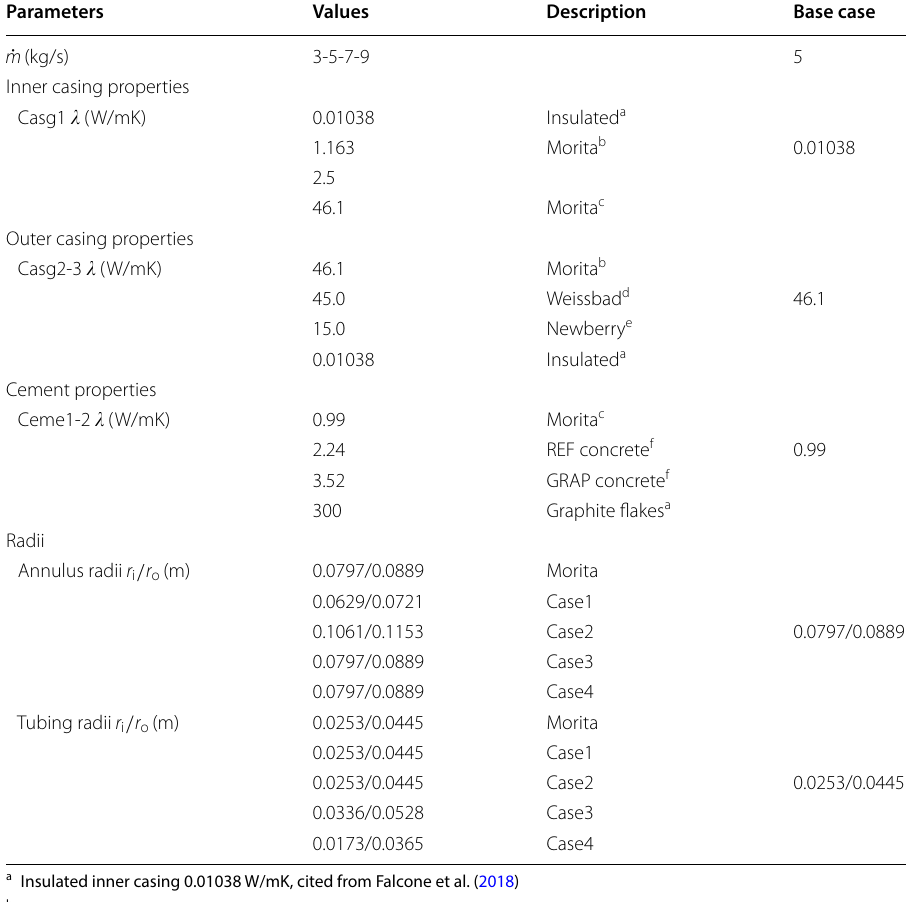
Table 6 Parameter changes investigated in the DBHE